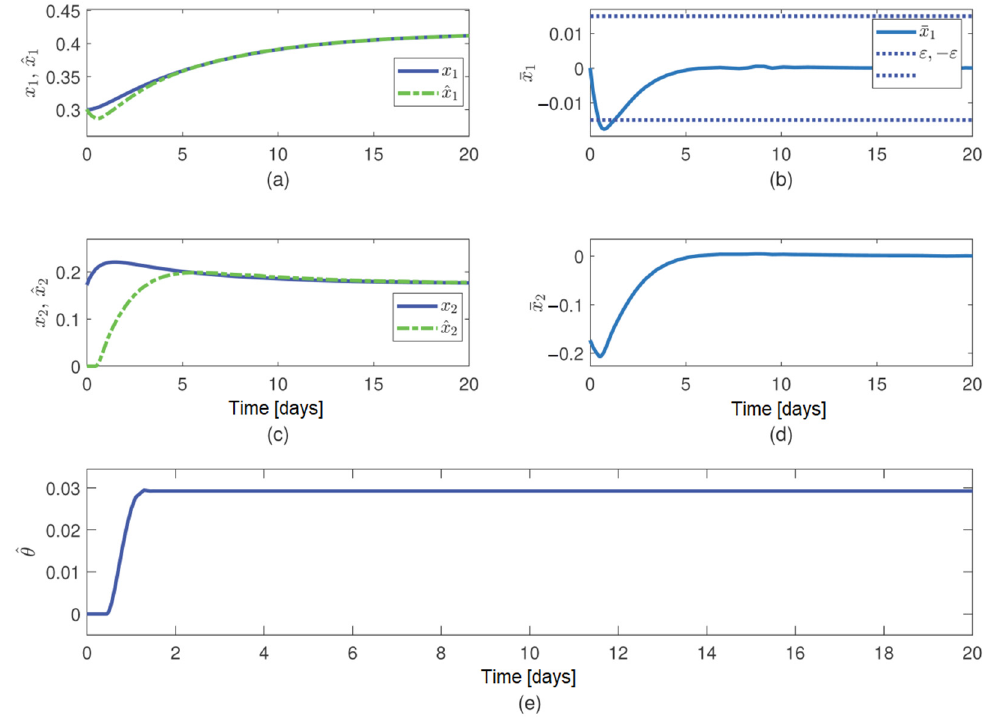
Figure 4. Performance of the proposed observer in the second simulation example: ( a ) trajectory of state x 1 and estimate ˆ x 1 ; ( b ) trajectory of the observer error for the known state, x 1 ; ( c ) trajectory of state x 2 and estimate ˆ x 2 ; ( d ) trajectory of the observer error for the unknown state, x 2 ; ( e ) trajectory of the updated parameter ˆ θ b